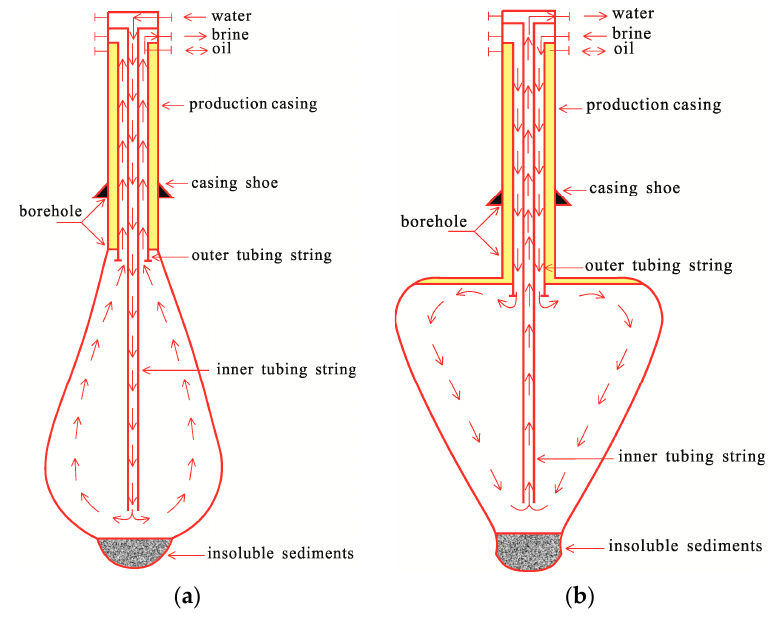
Figure 1. Schematic of direct circulation and reverse circulation in single-well cavity construction. ( a ) Direct circulation process; ( b ) reverse circulation